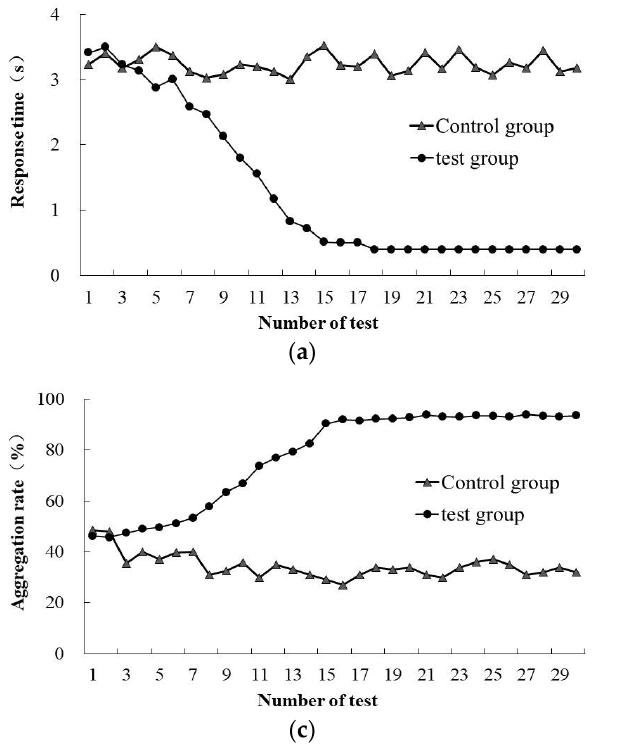
Figure 13. Changes in the time required to swim to the sound source and occurrence rate of juvenile Pagrus major .